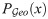
Mean probability PGeo(x).Mean probability PGeo(x) for all sequences x with the same complexity. Subfigure A: Sequences with |x| = 4. Subfigure B: Sequences with |x| = 5. Subfigure C: Sequences with |x| = 6. Subfigure D: Sequences with |x| = 7. Subfigure E: Sequences with |x| = 8.